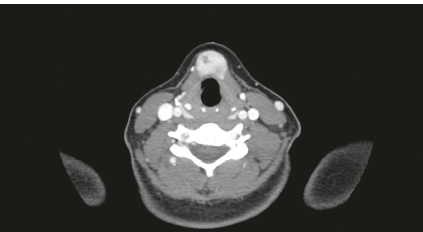
Figure 1: CT neck at the level of vertebra C4 showing a 1.6 × 2.0 × 2.9cm, enhancing, elliptically shaped mass located in the midline, within the anterior soft tissues of the neck.